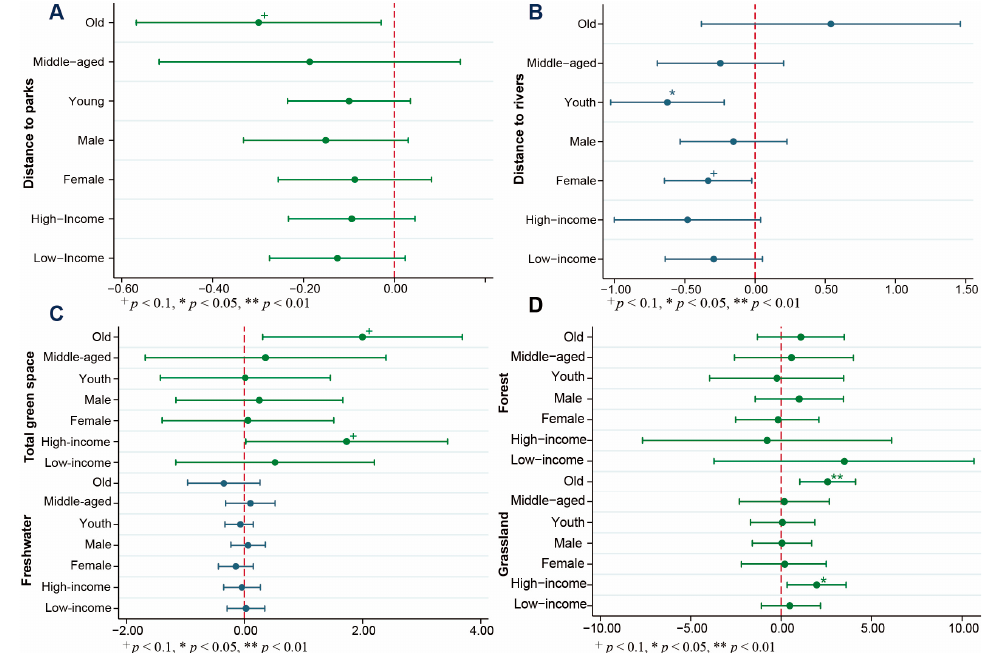
Figure 3. The regression results of the different subgroups. Note: ( A ) Coefficients between SRH and park distances by subgroup. ( B ) Coefficients between SRH and river distances by subgroup. ( C ) Coefficients between SRH and the coverage ratio of green space and freshwater by subgroup. ( D ) Coefficients between SRH and the coverage ratio of forests and grassland by subgroup.